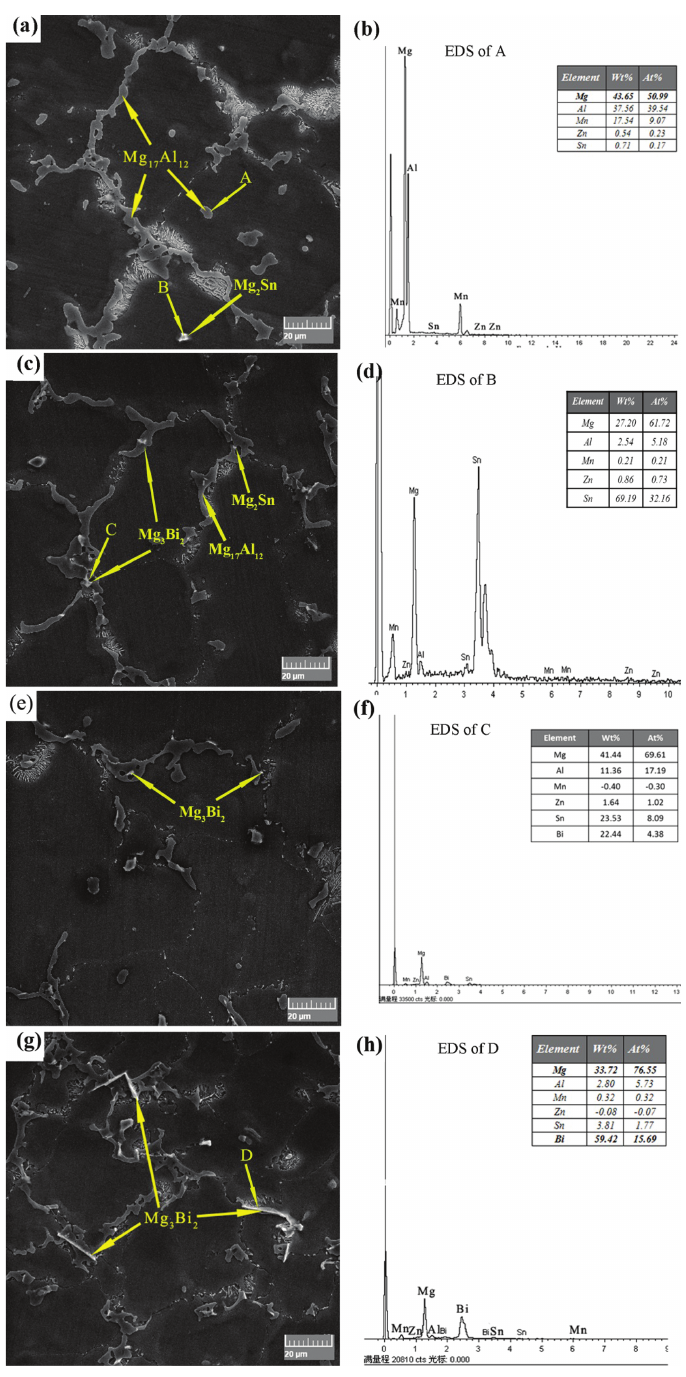
Figure 3: SEM morphology of as-cast AZ80 – 2Sn alloys with different Bi additions: (a) 0%Bi; (c) 0.5%Bi; (e) 1%Bi; (g) 1.5%Bi;(b) EDS of A; (d) EDS of B; (f) EDS of C; (h) EDS of